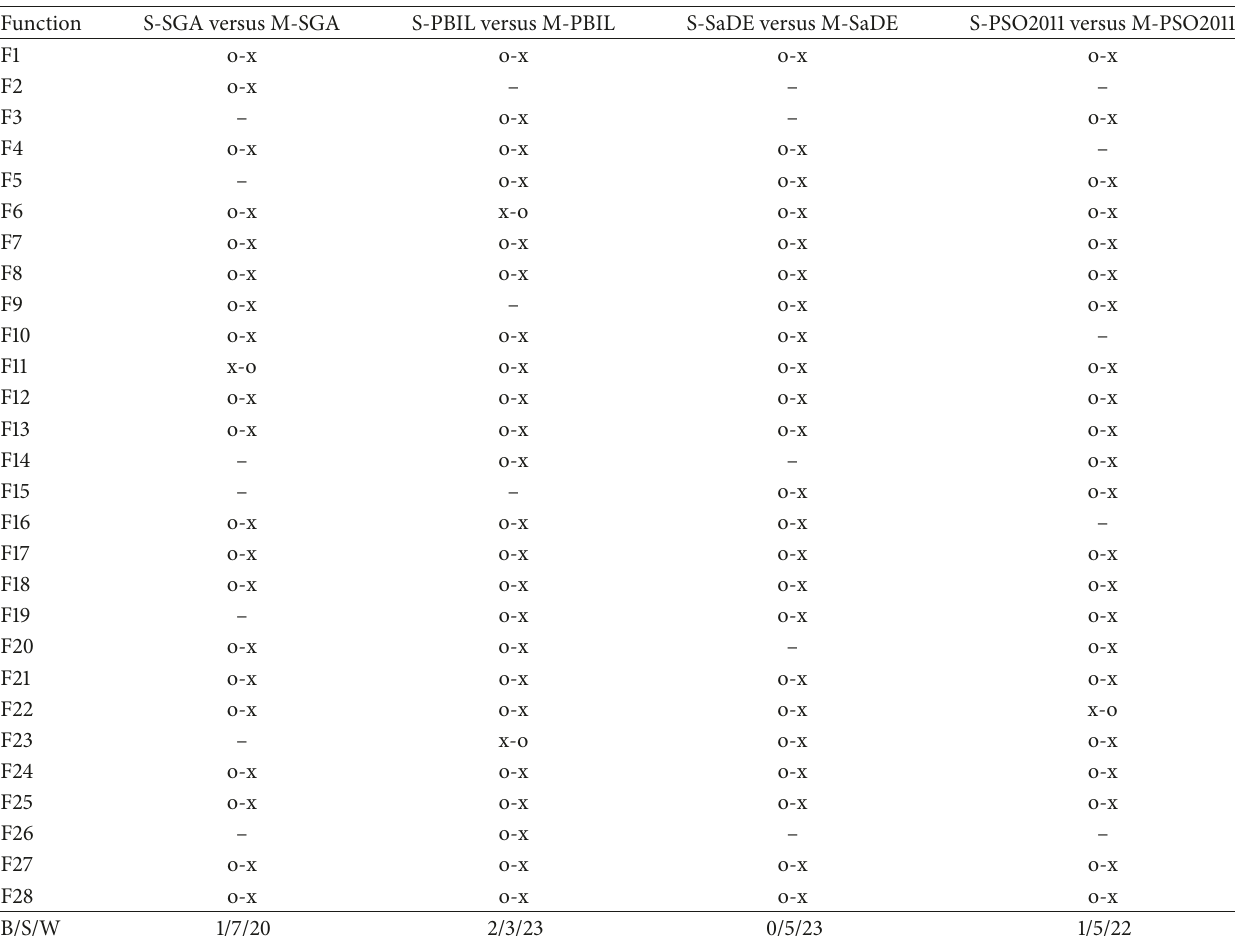
Table 4: Wilcoxon test results for pairwise algorithm comparisons. If the difference between the algorithms is statistically significant, the pairs are marked as follows: “x-o” shows that the left algorithm is better than the right one; “o-x” shows that the right algorithm is better than the left one. The B/S/W row at the bottom shows the total scores, where “B” denotes the number of times the left algorithm performs better, “S” denotes the number of times the two algorithms perform the same, and “W” denotes the number of times the left algorithm performs worse than the right one.